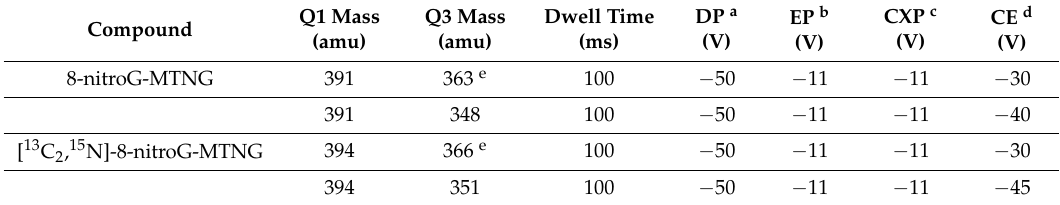
Table 3. Tandem mass spectrometry parameters for 8-nitroG-MTNG and [ 13 C 2 , 15